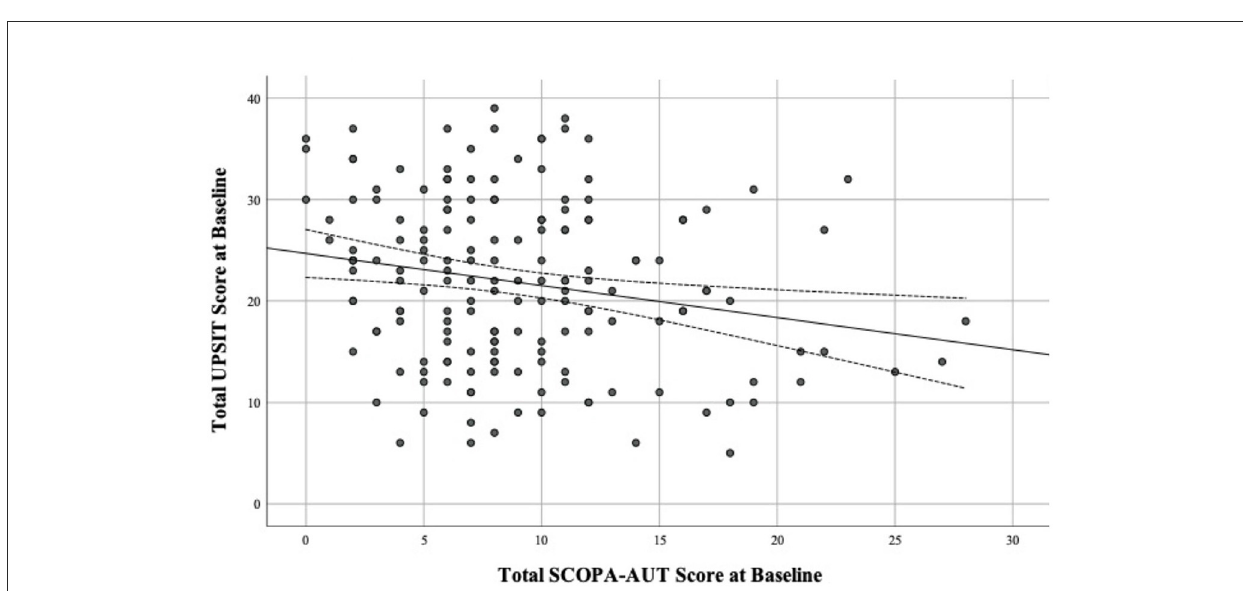
FIGURE4 Scatter plot of total UPSIT score by total SCOPA-AUT score at Baseline in Parkinson’s disease (PD), using Pearson correlation with 95% confidence